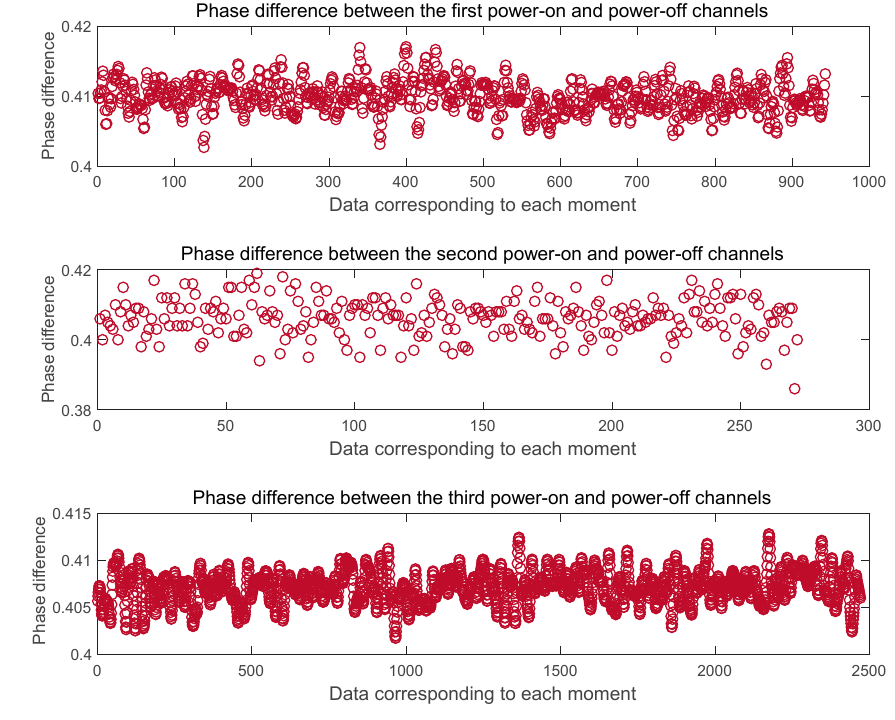
Figure 4. Test of influence of power on/off on L1 phase difference results between channels.